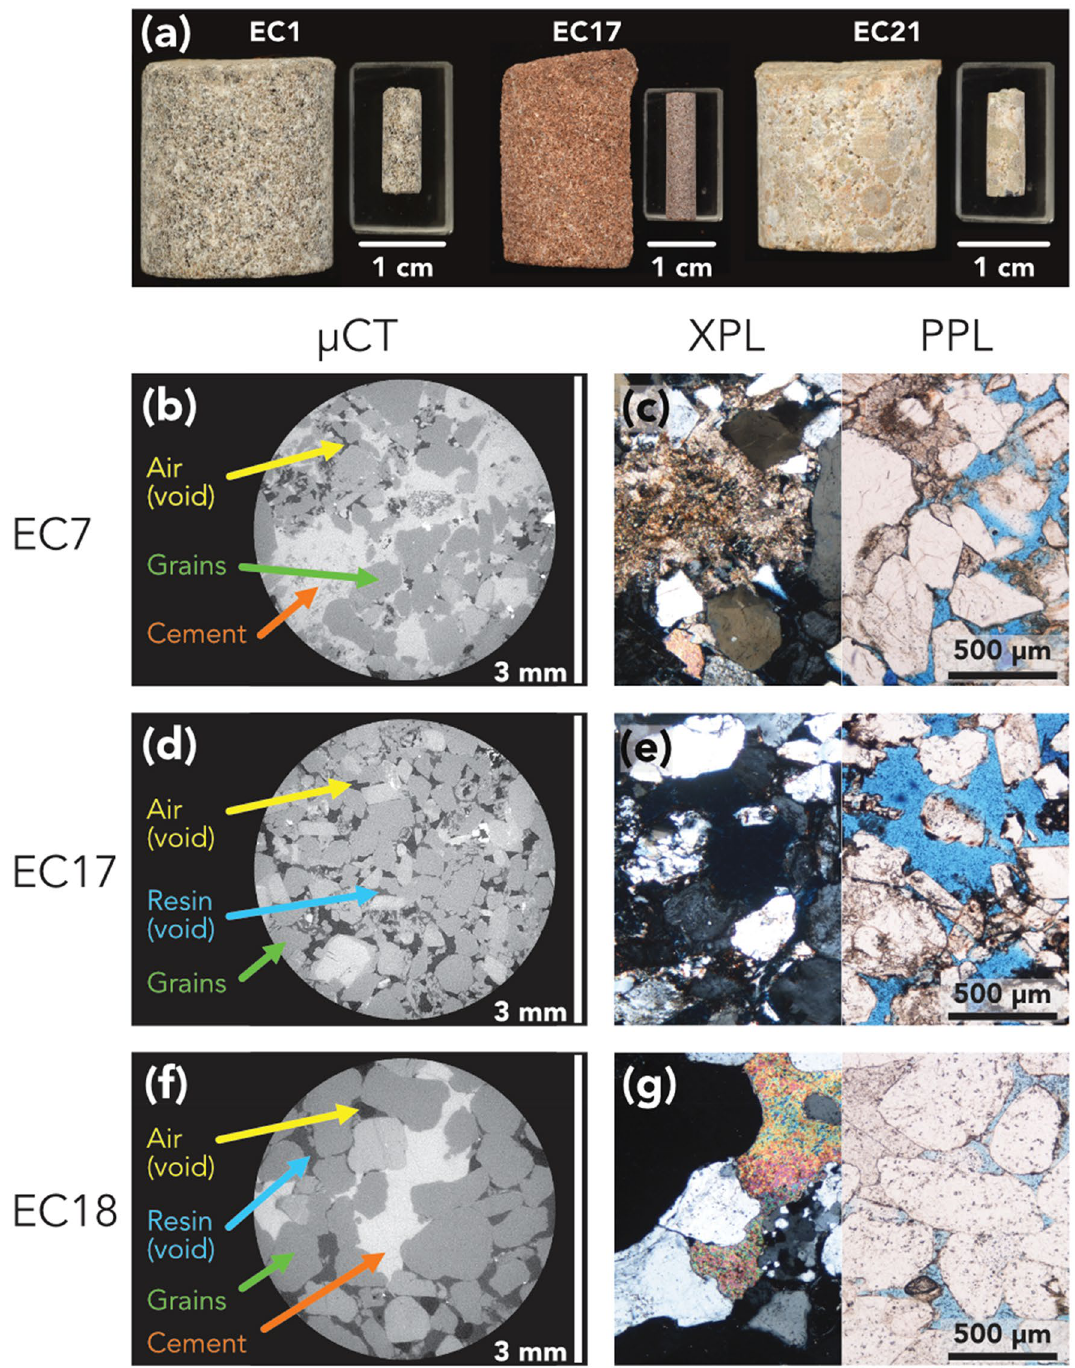
Figure 1. Examples of the material used for imaging and the resulting μCT and optical microscopy images in both XPL and PPL. ( a ) Shows the cut plug and mini-plug used for μCT imaging from three samples: EC1, EC17 and EC21, showing the range of materials from the English Channel sample suite. ( b – g ) show μCT images with phases labelled and XPL and PPL optical microscopy images of samples EC7, EC17 and EC18 respectively. In the PPL images the blue phase is a dyed resin to facilitate identification of the pore